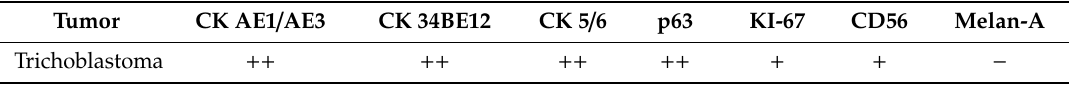
Table 2. Immunolabeling patter of the examined trichoblastoma.